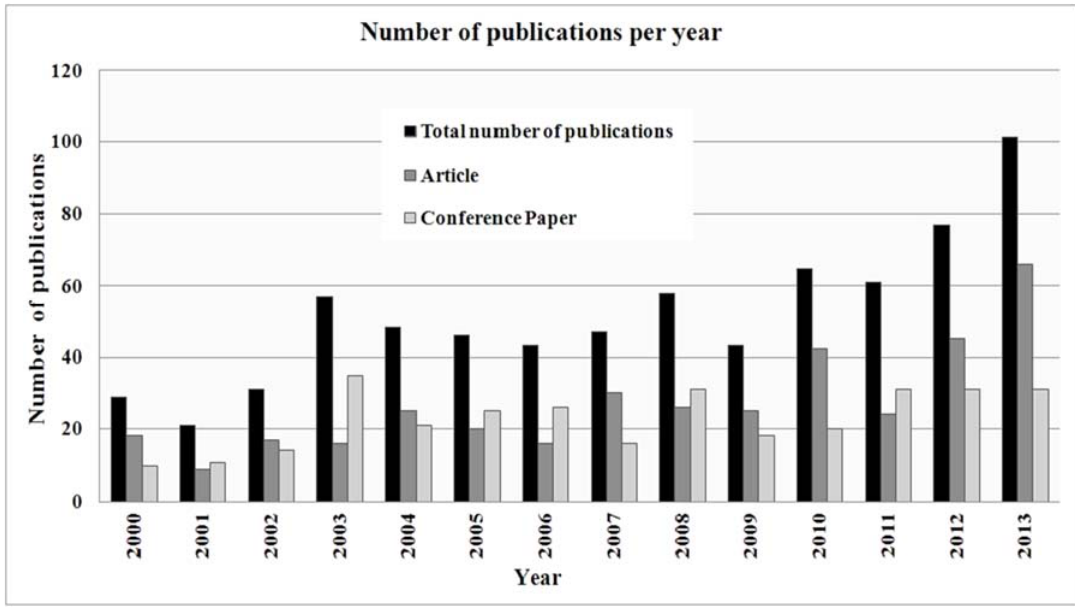
Figure 1. Annual publication output.